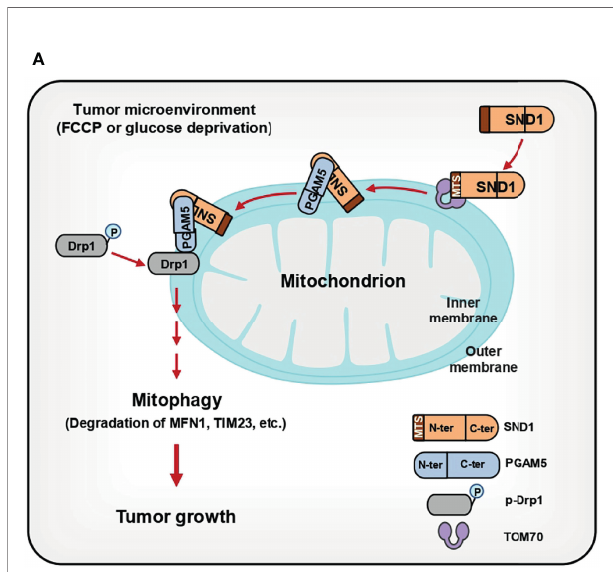
FIGURE 9 | Summary of SND1-mediated mitophagy through PGAM5 during tumor progression. (A) Summary: SND1, as an evolutionarily conserved protein, is unexpectedly enriched in the outer and inner membranes of mitochondria through its MTS with the assistance of TOM70. In the mitochondria, SND1 binds to PGAM5 through its C-terminus and this interaction is crucial for SND1-mediated mitophagy, such as the degradation of MFN1, TIM23, and COX4, and dephosphorylation of p-DRP1 S637 . Finally, SND1-induced advantages of cell proliferation and tumor growth depend on PGAM5-mediated mitophagy and its mitochondrial